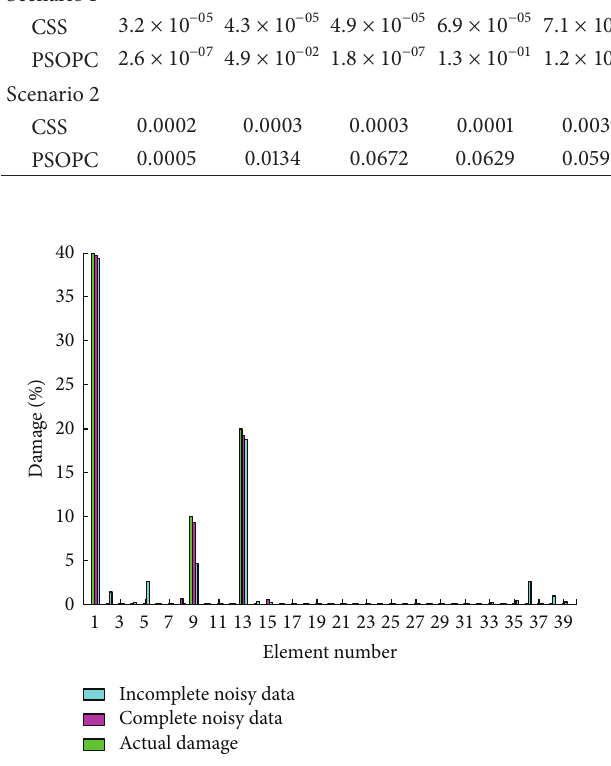
Figure 12: Damage distribution of plane frame using the complete and incomplete noisy data in Scenario 1.